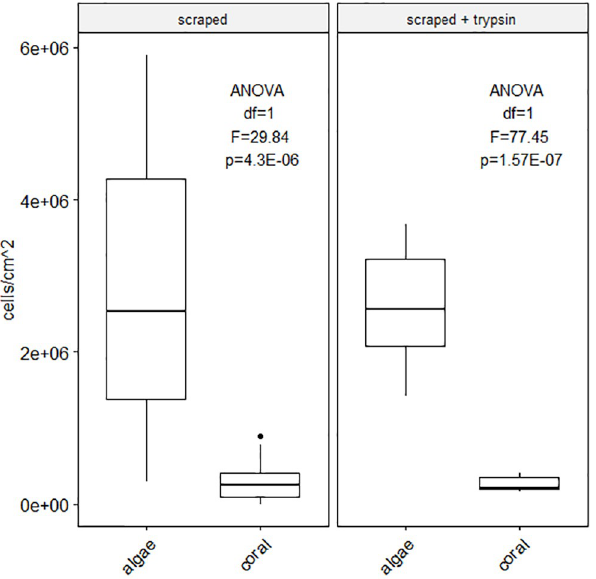
Fig 4. Cell dissociation method combination efficacy. Average algae cell and coral host cell yields as a factor of the origin of cell counted: Initial cell dissociation performed by scraping, remaining cells (on the skeleton) were dissociated using trypsin incubation for 1 hour. Significant difference between algae cell yield and coral cell yield by scraping and by scraping associated to trypsin digestion (scraped yield ANOVA df = 1, F = 29.84, p = 4.3E-06; scraped + trypsin yield ANOVA df = 1, F = 77.45, p = 1.57E-07) but no statistically different yields of algae cells and coral cells between methods (algae cell yield ANOVA df = 1, F = 0.057, p = 0.81; coral cell yield ANOVA df = 1, F = 0.48, p = 0.49) S3